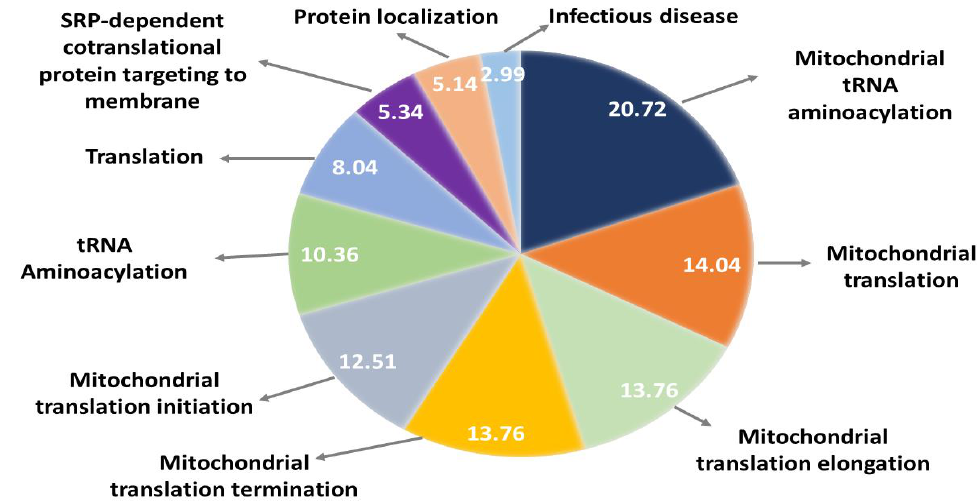
Figure 3. Reactome pathway enrichment of the network created with the 238 mammalian orthologues. Enrichment ratios are given for each pathway. Enrichment ratios were obtained from WebGestalt.